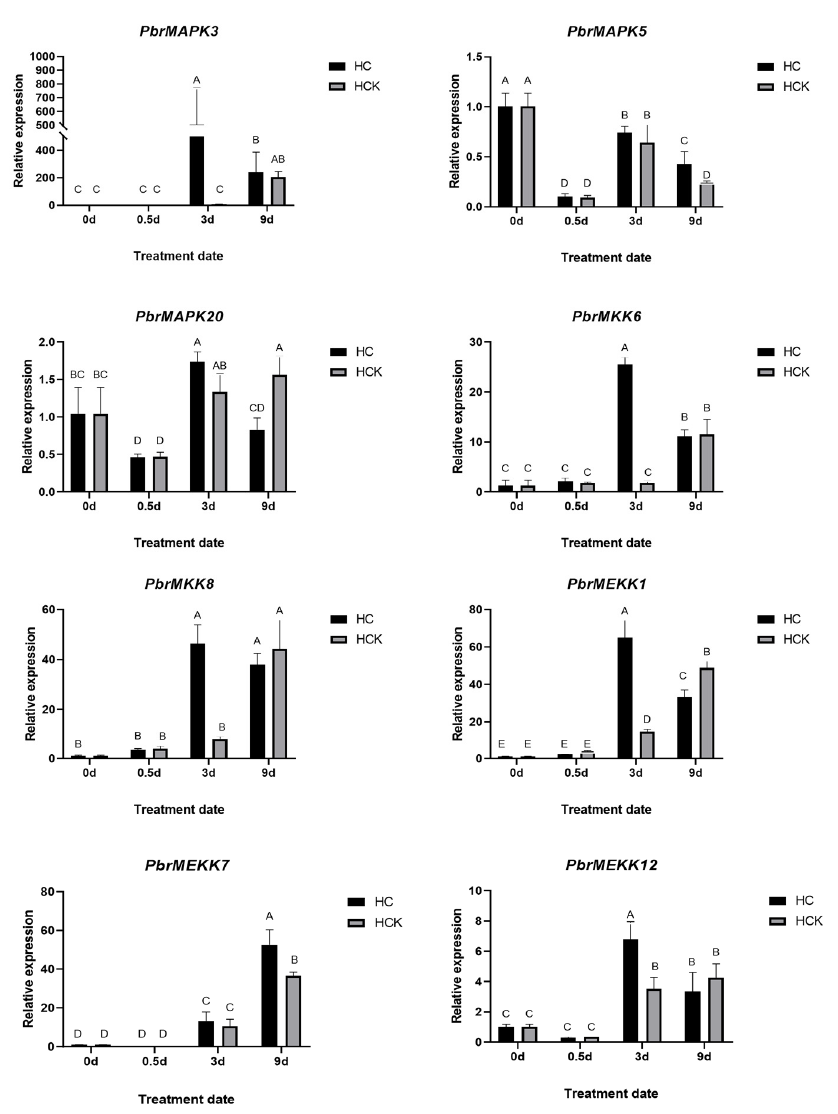
Figure 5. Differential expression for 8 MAPK cascade genes response to 1% HC treatment at 0 day, 0.5 day, 3 day, and 9 day, with water treatment as control. The above letter ABCDE is the significant difference analysis result after graphPad analysis.